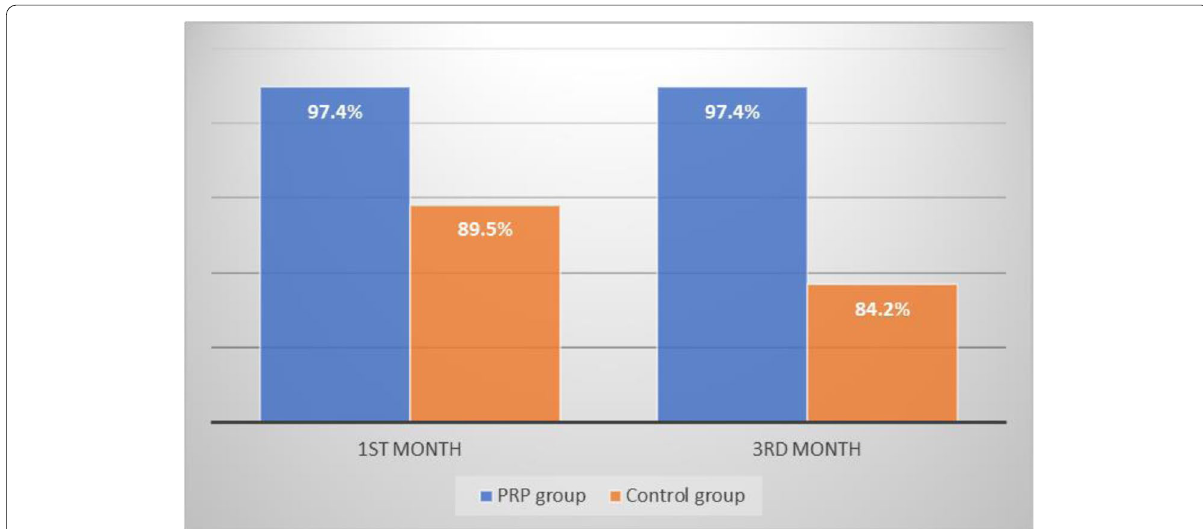
Fig. 9 Graphical representation of graft uptake at 1st and 3rd months among both groups